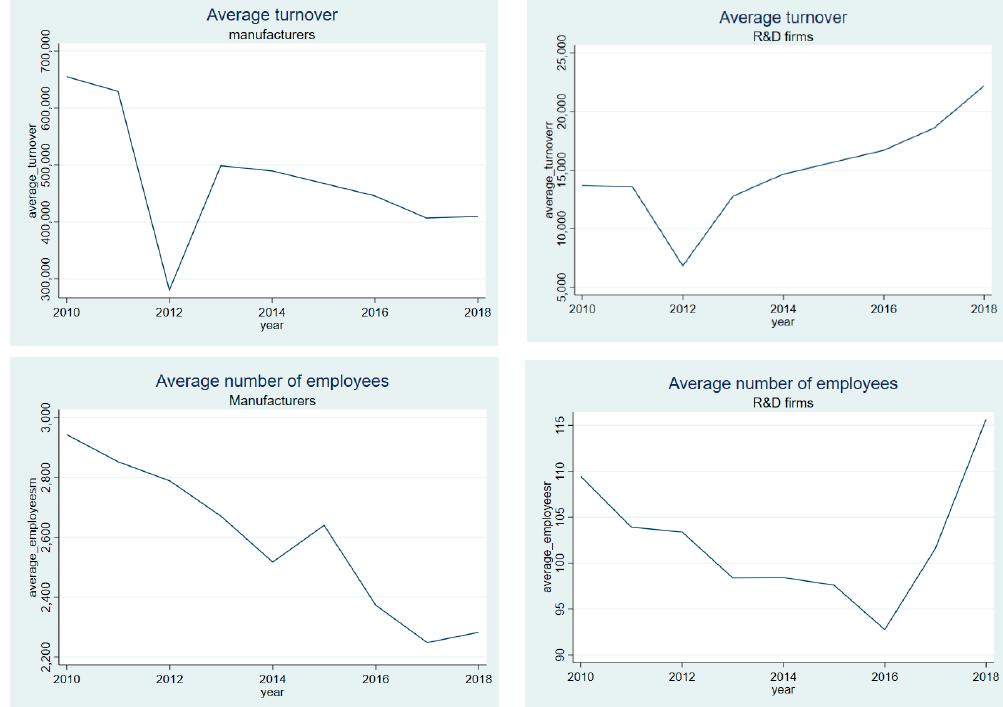
Figure 2. Average real turnover (in constant euros of 2015) and average number of employees over time by main activity. Notes: The figure displays the time pattern for average real turnover and average number of employees over 2010–2018, disaggregated by main activity of firms. Averages have been computed from the data year by year. Two main categories are considered: firms whose main activity is the manufacture of basic pharmaceutical products (manufacturers), and companies focused on research and experimental development on biotechnology (research and development (R&D) firms). Average turnover exhibits a decreasing trend over the period, with a big drop in 2012 for manufacturers, and an increasing trend for R&D firms since 2013. Average number of employees decreases over the period for the first category of firms and increases since 2016 for the second. Source: own elaboration with data from the Amadeus data basis).